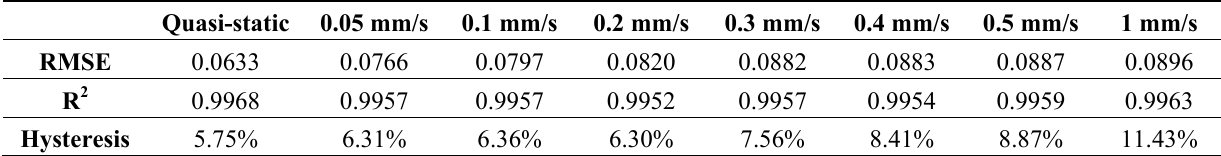
Table 2. RMSE, R 2 and maximum hysteresis for force-to-deformation characterization of